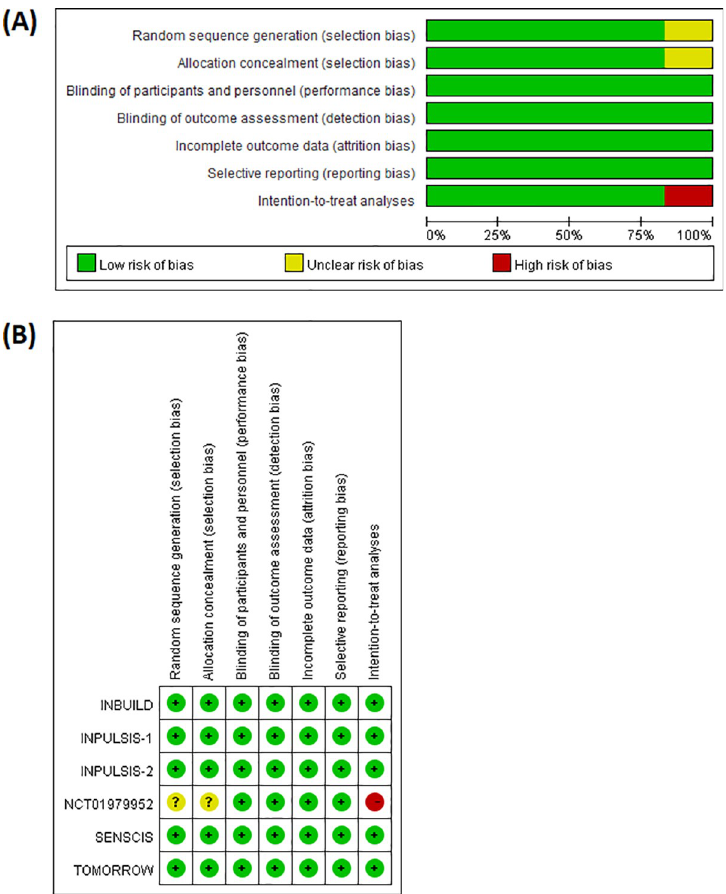
Fig 4. Quality assessment of included studies. (A) Risk of bias summary for the included studies, (B) Risk of bias for each individual study.